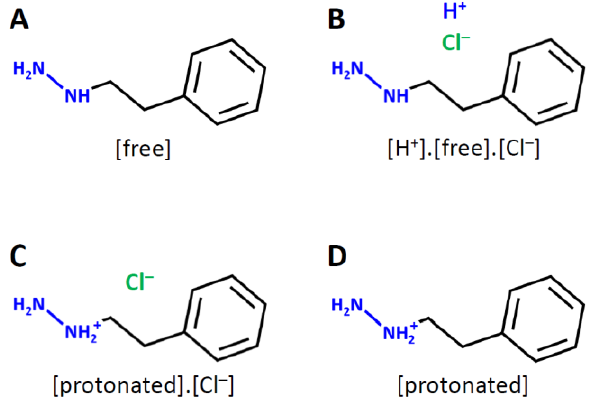
Figure 1. Chemical forms of an example compound: a free form ( A ), a frequently used formal salt form ( B ), an actual salt form ( C ), and a protonated form in aqueous solution ( D ).